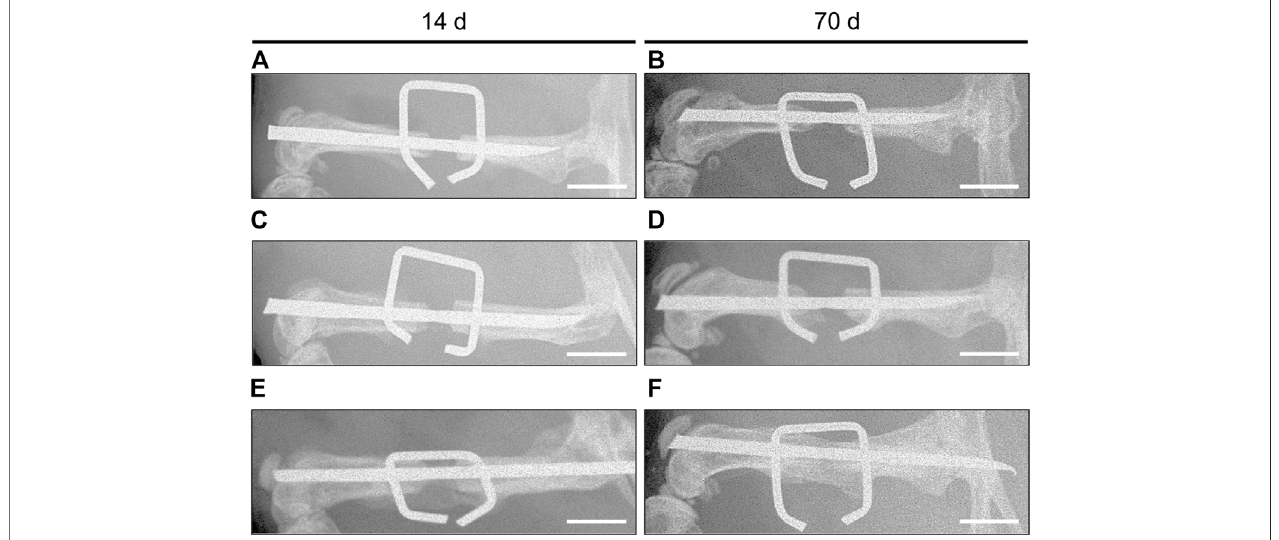
FIGURE 2 | X-ray analysis of mouse femurs. A-F : X-rays of osteotomized mouse femurs with a segmental defect of 1.8 mm stabilized by the “ pin-clip ” technique 14 days (A, C, E) and 70 days (B, D, F) after osteotomy. Images of control (A, B) and MCM (C, D) exhibit no osseous bridging with a large persisting gap between the two bone fragments, indicating non-union formation, while images of MCM + VB (E, F) show callus formation after 14 days (E) and fully osseous bridging after 70 days (F) . Note that images of MCM + VB at 70 days (F) show signs of remodeling between the brackets of the clip, while images of controls at 70 days (B) exhibit that adjoining bone fragments narrowed towards the osteotomy gap as a typical sign for atrophic non-union formation. Scale bars: 2